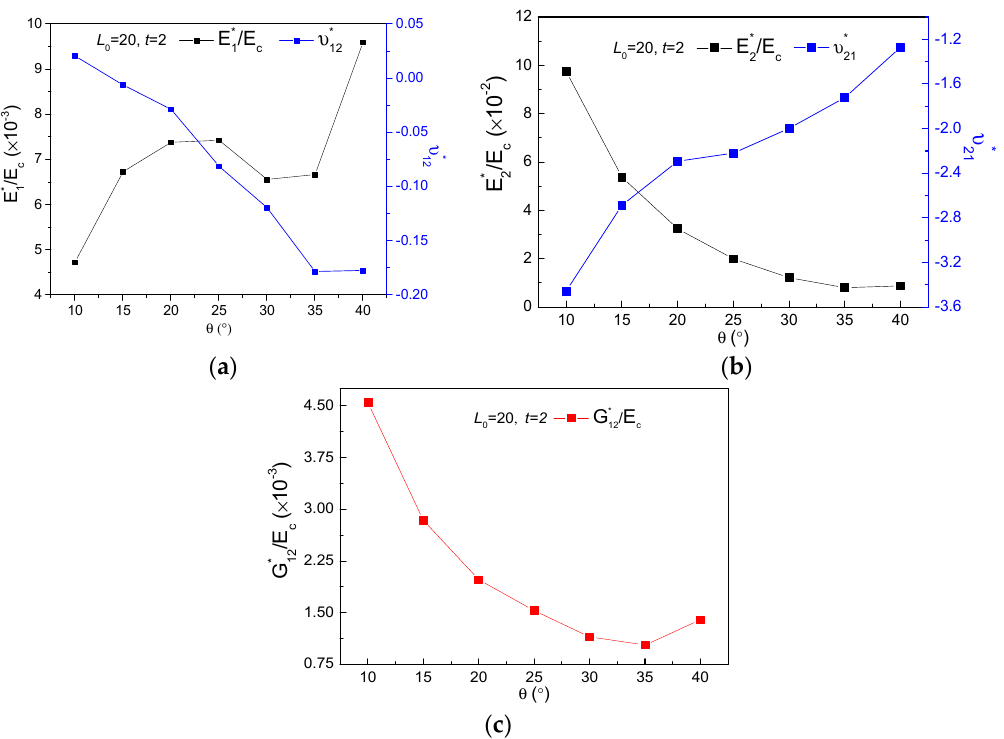
Figure 5. The variations of e ff ective mechanical properties verse thickness t : ( a ) E ∗ and ν ∗ , ( c ) G ∗ / E c . Polymers 2019 , 11 , x FOR PEER REVIEW 21 12